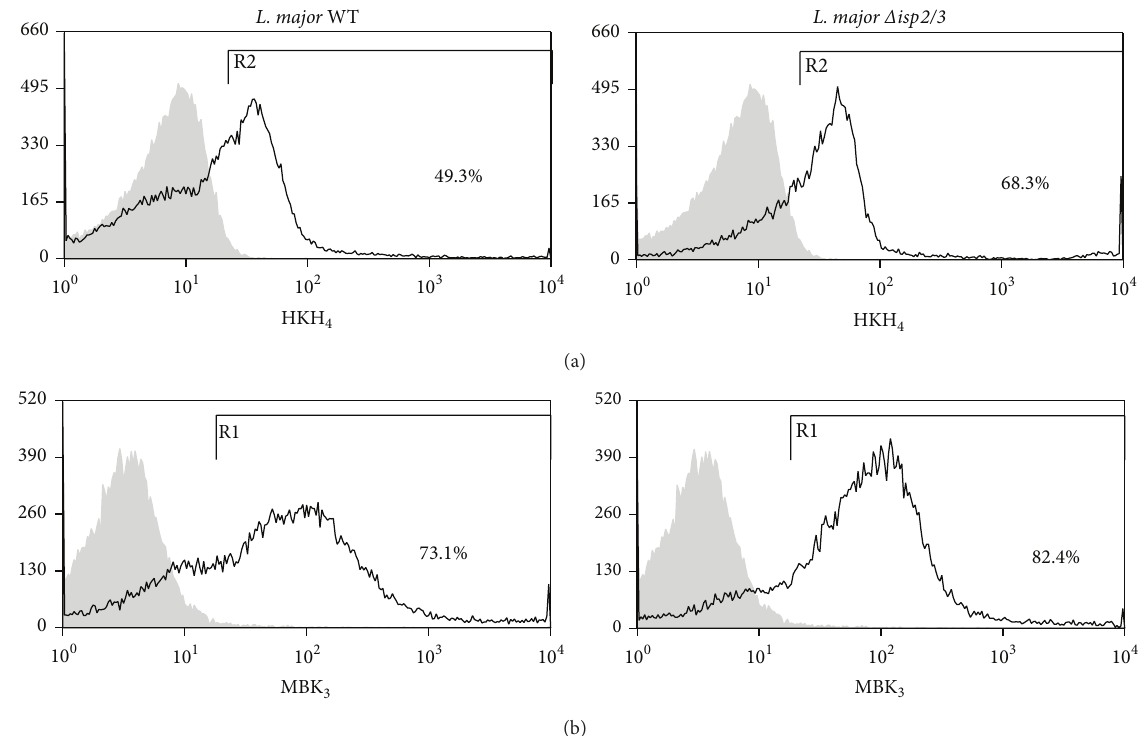
Figure 3: Evidence of differential display of kininogens and BK epitopes on surface of WT L. major versus Δ𝑖𝑠𝑝2/3 promastigotes. WT and Δ𝑖𝑠𝑝2/3 promastigotes were washed 3x before incubation with mAbs against D1 or D4 (BK epitope) of kininogens, HK/LK (HKH for HKH 4 or IgG1 for MBK 3 staining) were used as specificity controls. Binding of primary IgG MBK 3 (b), resp.) for 1h. Unrelated Ab (IgG 2 a was assessed by incubating the cells with a secondary FITC-labeled anti-mouse IgG antibody for 1h. The graphs represent the percentage of HK/LK adsorption and are representative of two independent experiments performed in